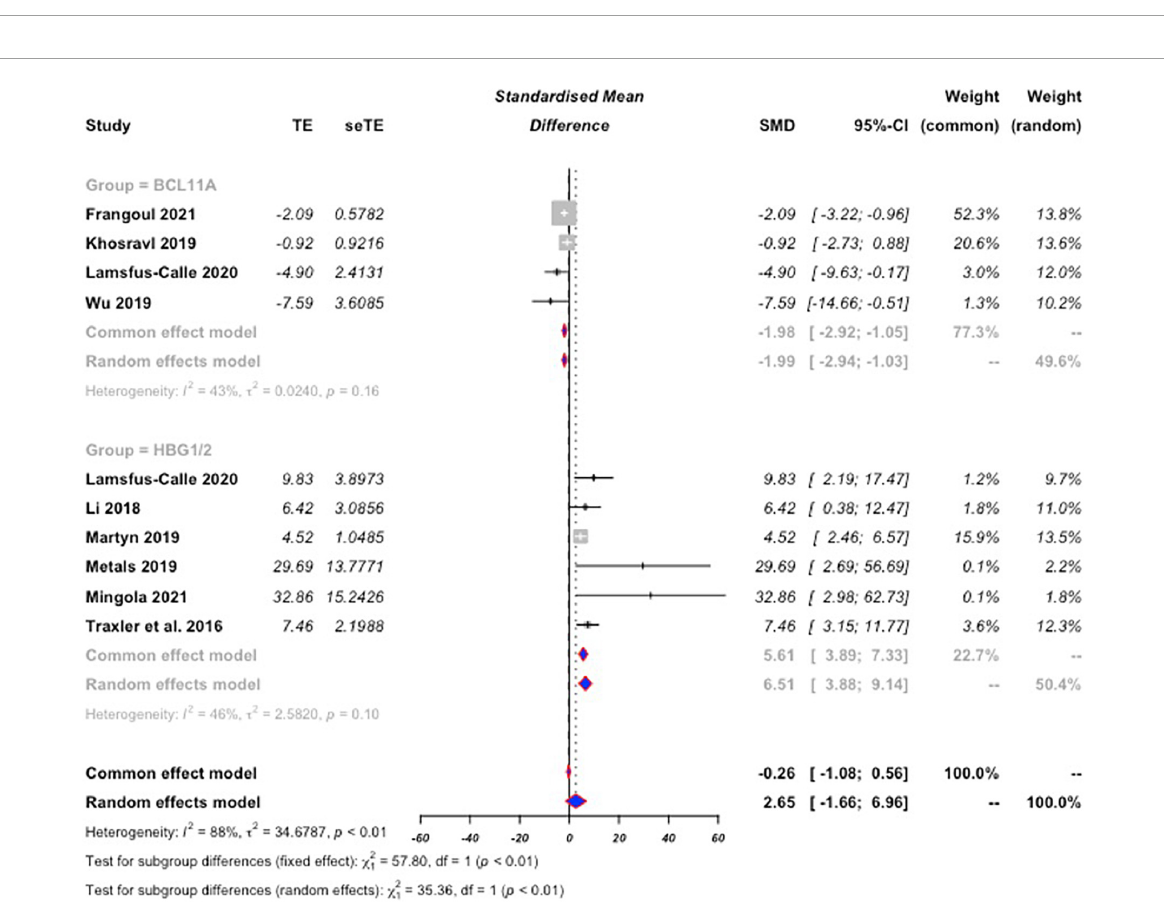
FIGURE3 Forest plot for BCL11A and HBG1/2. Standard mean difference (SMD) values were calculated for both BCL11A, and HBG1/2 based on percent HbF expression as a total of hemoglobin expression following CRISPR editing compared to baseline. SMD values are negative for BCL11A not as an indication that expression levels dropped, but as a differentiator from the positive values of HBG1/2. The calculated SMD values from the collection of BCL11A studies was then compared to the calculated values from HBG1/2 for comparison of efficacy of HbF expression induction. The random effects model was used due to significant heterogeneity between the included studies. Editing of HBG1/2 significantly increased HbF expression by comparison to BCL11A editing ( p <